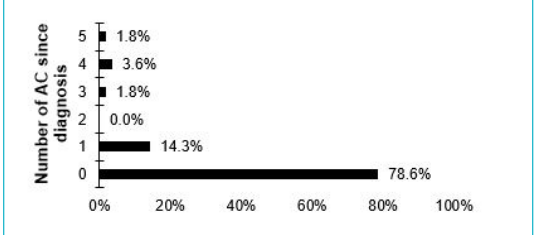
Figure 1: number of adrenal crisis per